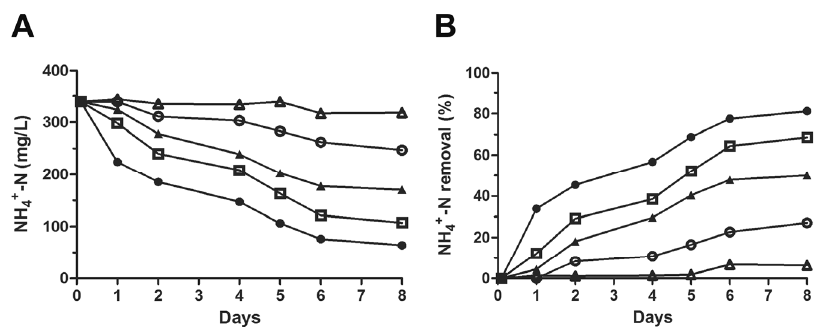
Figure 3. Effects of salt stress on NH 4+ removal rate by the activated sludge. The activated sludge was incubated in LMM essentially as described in the legend of Figure 2. Chloride ion (Cl − ) concentrations were adjusted to 0.5 ( ● ), 2 ( □ ), 4 ( ▲ ), 6 ( ◌ ) and 10 ( Δ ) g/L and NH 4+ -monitored, using Nessler’s test, as a function of time ( A ) and expressed as a removal percentage ( B ). Data represent the average of three independent experiments and the standard deviation is ~10%.